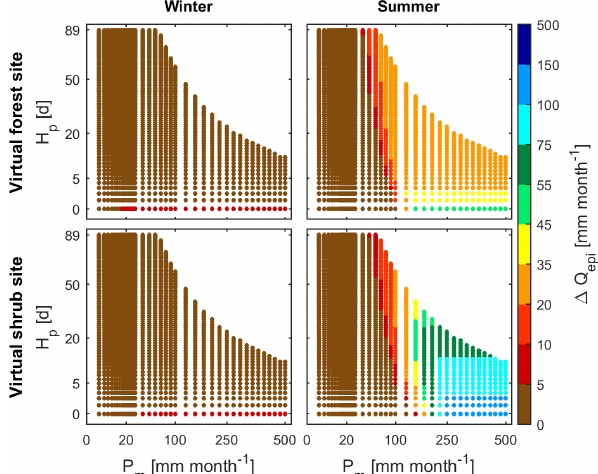
− Q forest ) epi epi